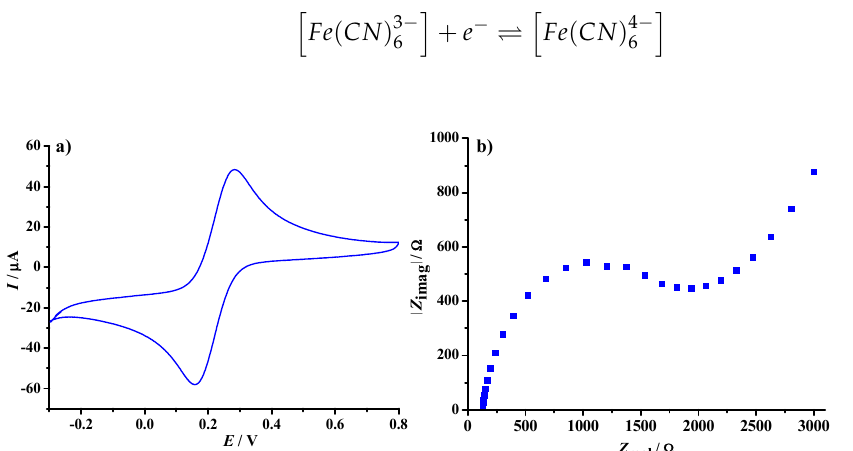
Figure 3. Current response ( a ) and Nyquist plot ( b ) of the bare graphite electrode immersed in 5.0 mM K 3 [Fe(CN) 6 ] with 0.1 M KCl solution. Cyclic voltammetric signature obtained at a scan rate of 50 mV/s; impedance spectra recorded within 1 mHz to 1 MHz and Δ E = ±10 mV.